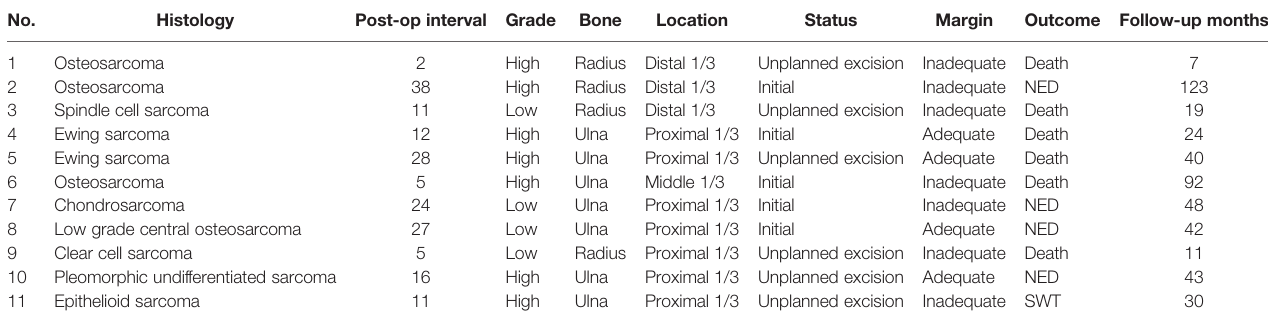
xation ( Figure 5 ), (3) long segment fi bula autograft and fi xation (less than 1/2 defect), and (4) ipsilateral ulnar osteotomy to replace the radial defect ( Figure 6 ). TABLE 2 | Local Recurrences by Tumor Type, Grade, Location, Margins.